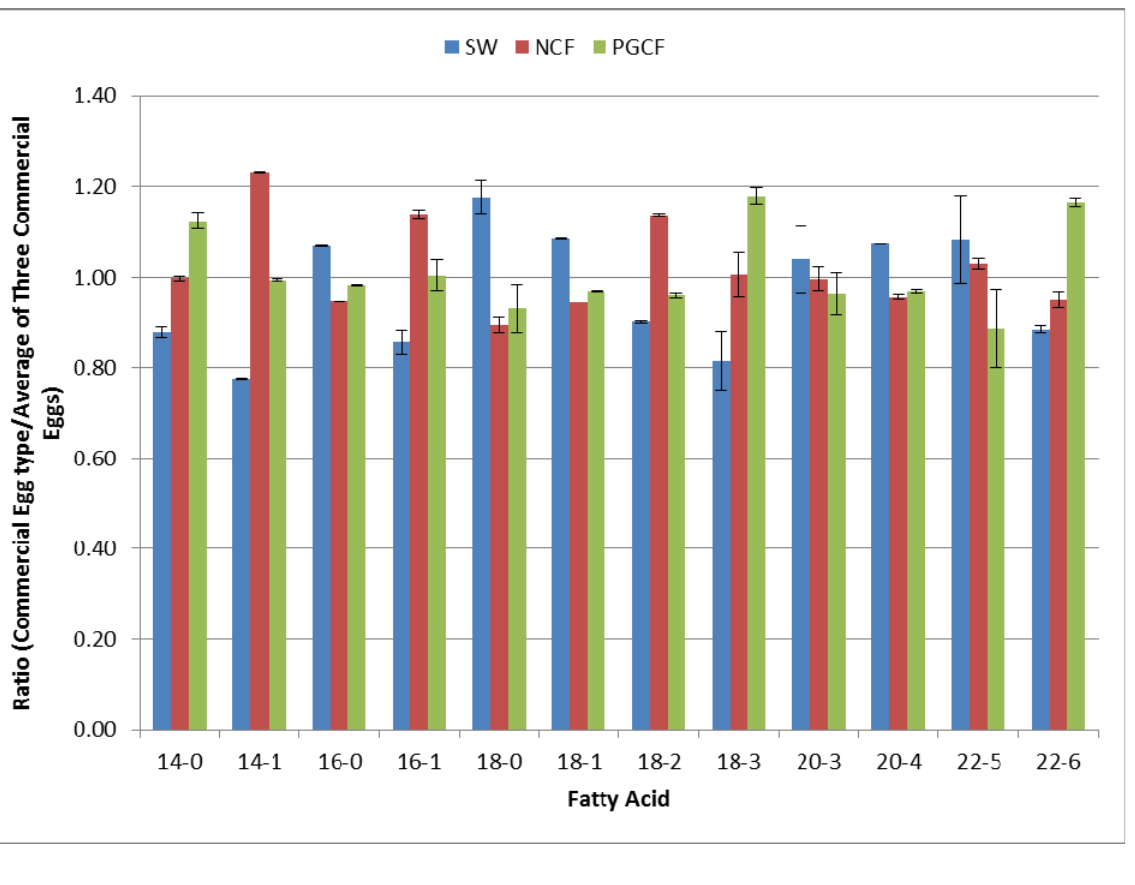
Figure 2. Multiplexed quantification of fatty acids in hydrolyzed egg lipid extracts from caged and cage free chickens. The results of quantification are displayed as ratios between the commercial sample and the average of the three commercial